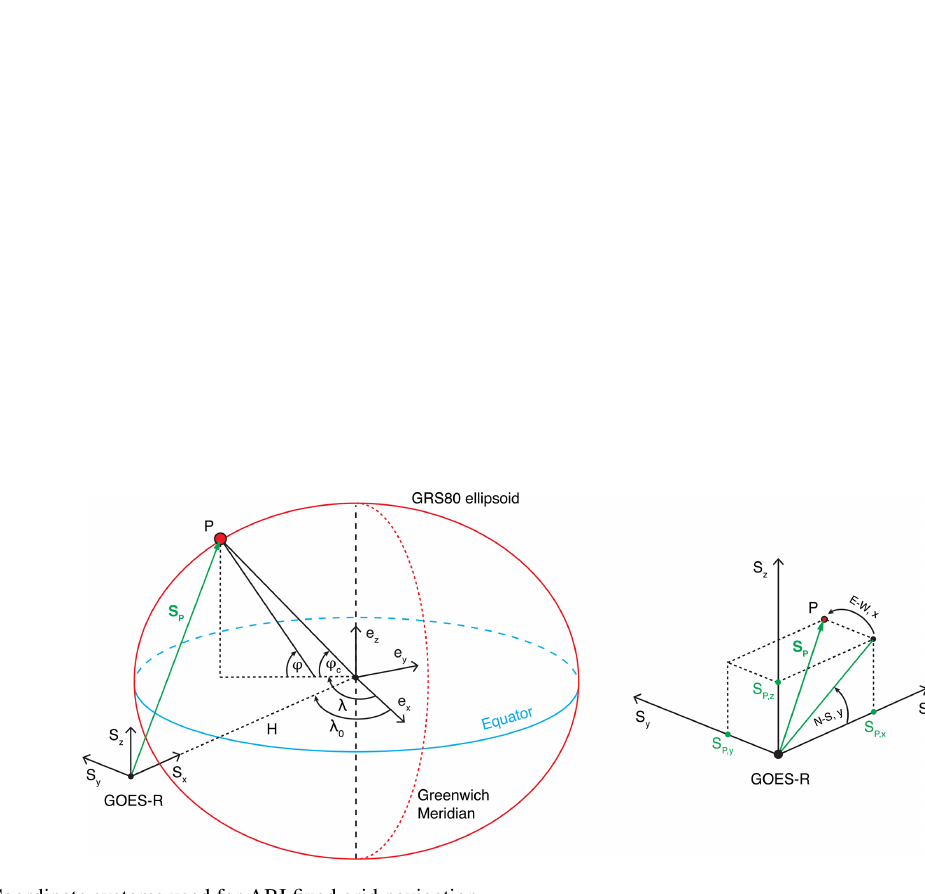
Figure A1. Coordinate systems used for ABI fixed grid